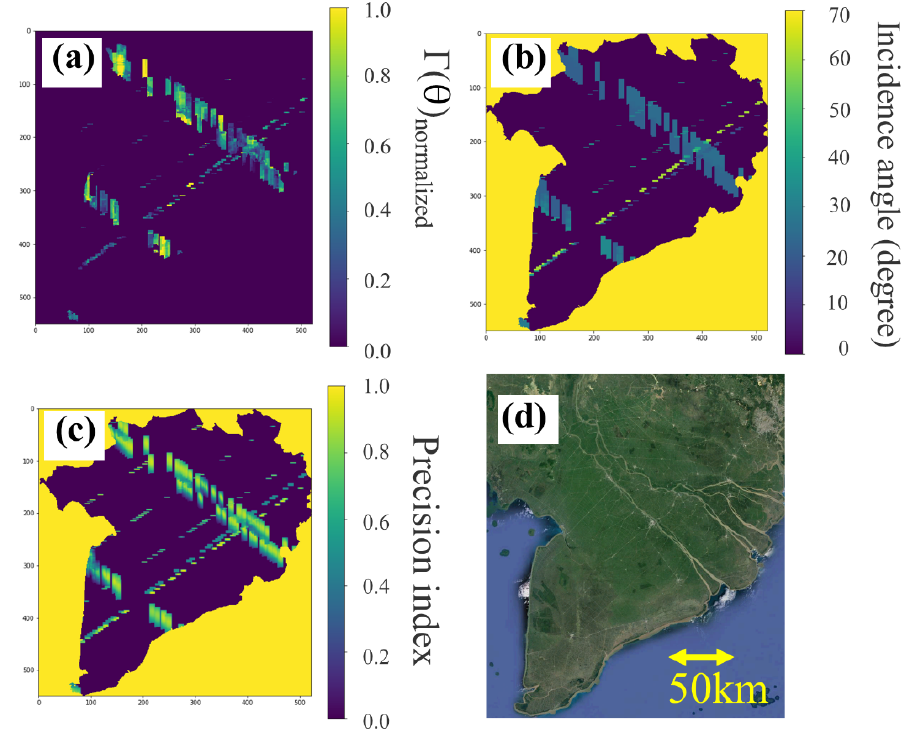
Figure 4. A sample of the Lv. 2 daily product ( a ) Γ ( θ ) normalized ; ( b ) incidence angle; ( c ) precision index clipped at the Mekong Delta ( d : Optical image) on 4 January 2021.